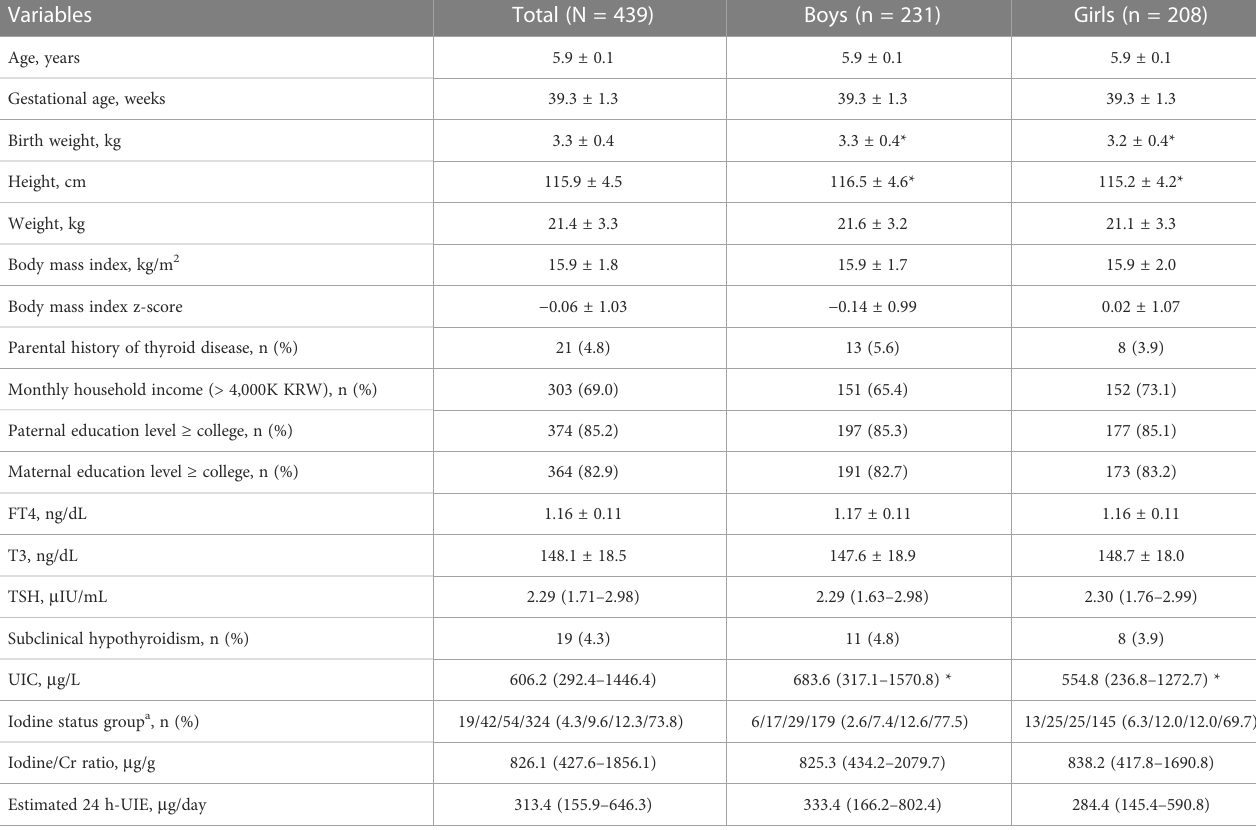
TABLE 1 Clinical characteristics of study